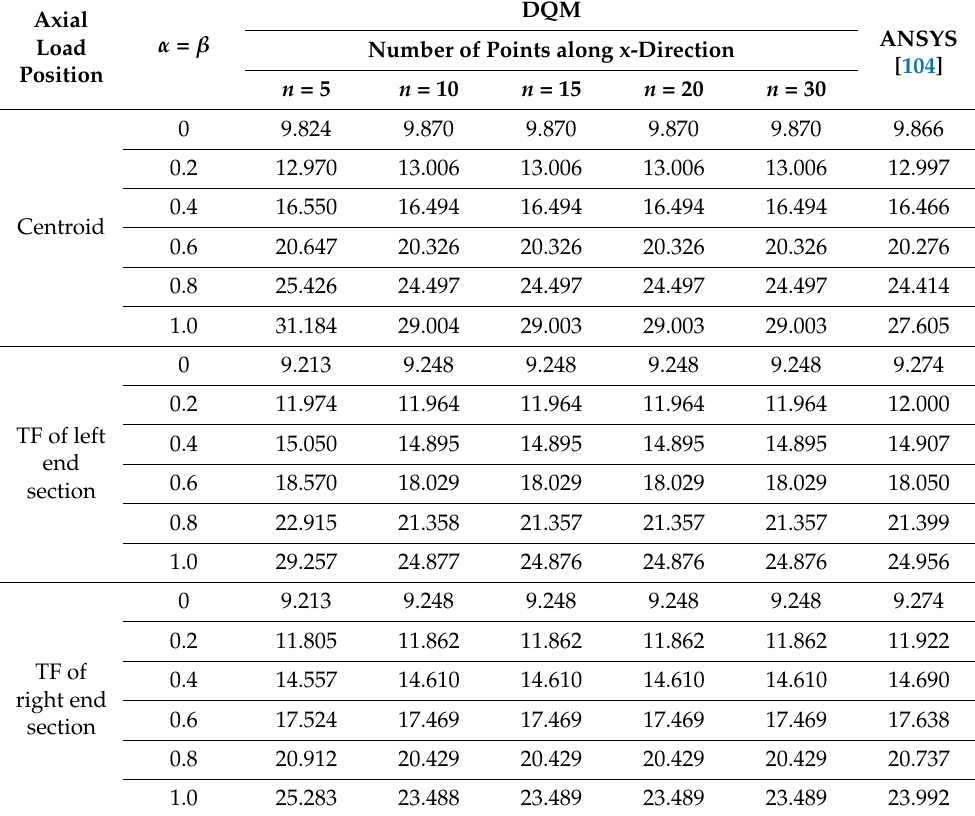
Table 1. Dimensionless buckling load ( P nor ) for local tapered homogenous I-beams (alumina) with different tapering parameters and loading